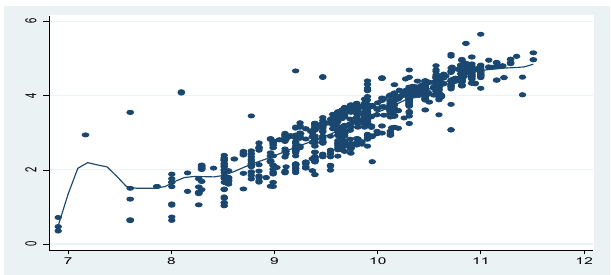
Figure 1. Positive relationship between farm size and rice